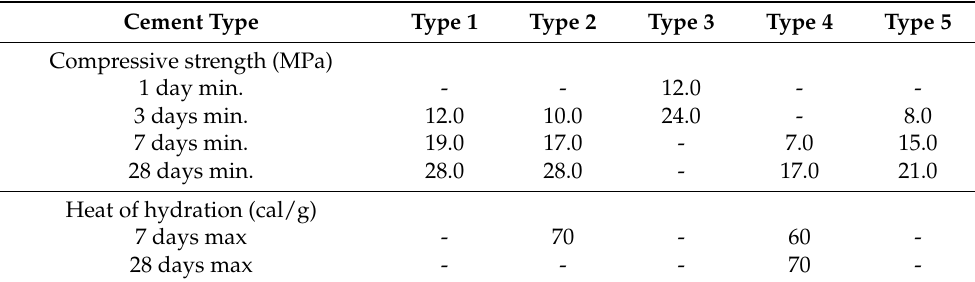
Table 1. Standard physical specifications of the cement types as defined in ASTM C150 [2].